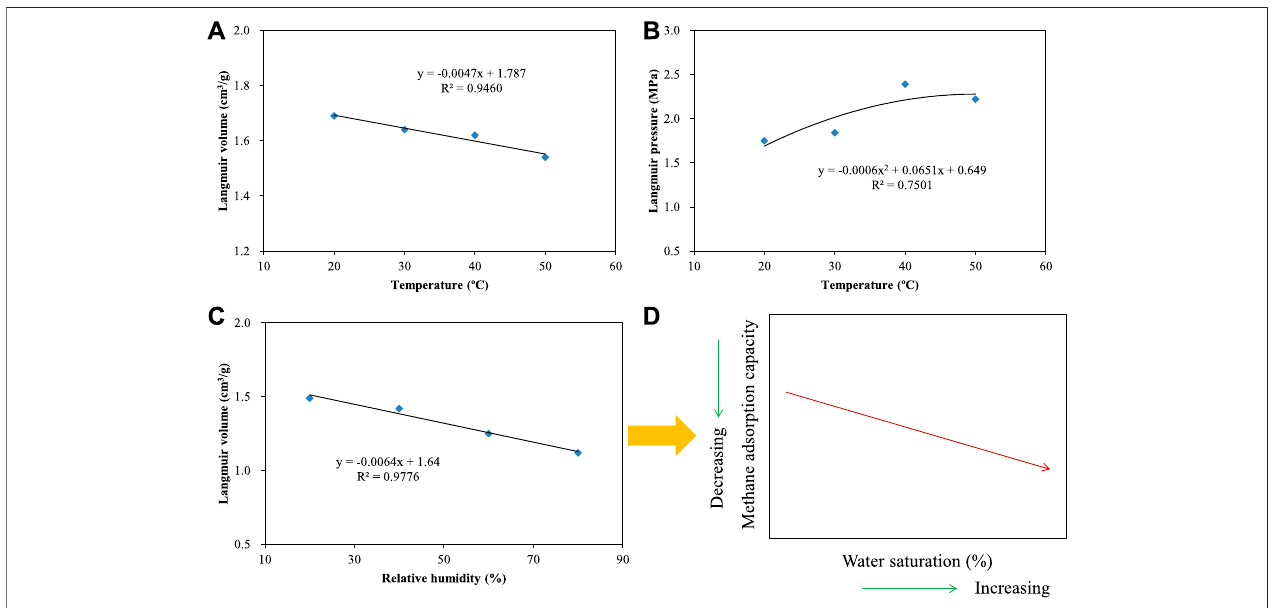
FIGURE 2 | (A) : Correlation between Langmuir volume and temperature. (B) : Correlation between Langmuir pressure and temperature. (C) : Correlation between Langmuir volume and relative humidity. (D) : Correlation between methane adsorption capacity and water saturation.